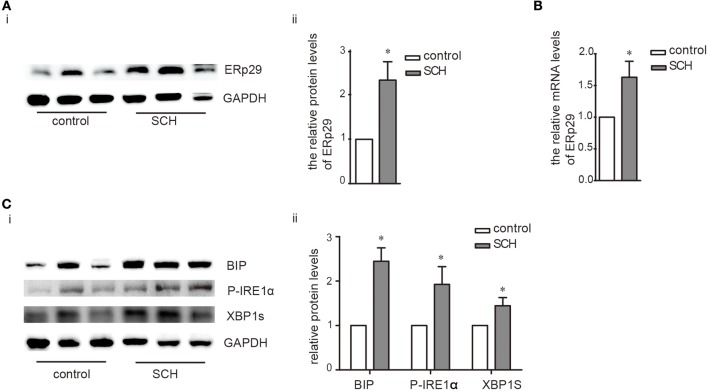
Hepatic ER stress was induced in SCH mice. Male C57/BL6 mice were given methimazole (MMI, 0.08 mg/kg·BW·d, SCH group) or a corresponding volume of vehicle (control group) for 14 weeks, the expression of proteins in ERS pathway were detected by western blot (n = 4–6). (A) The protein expression of ERq29 was detected by western blot. (B) The mRNA expression of ERq29 was detected by Real-time PCR. (C) The expression of proteins in the Bip/IRE1α/XBP-1 pathway were detected by western blot. The data are presented as the mean ± SD. *p < 0.05 compared with control.